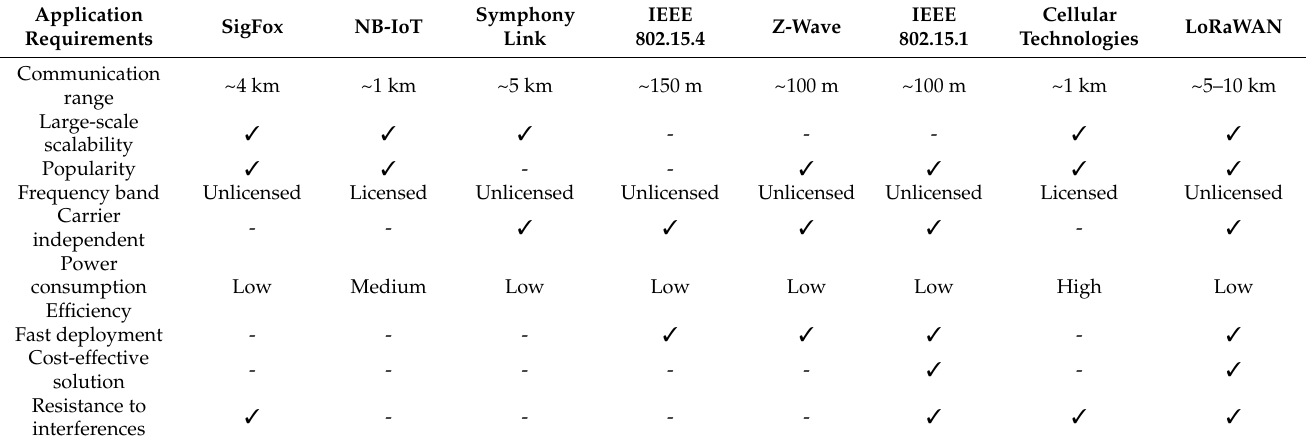
Table 1. IoT communication protocols that can be implemented in patient monitoring